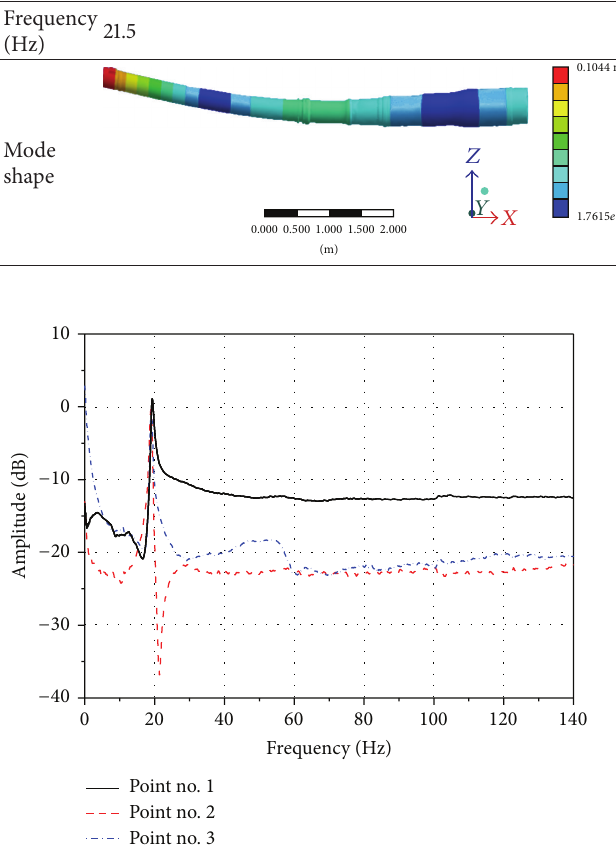
Figure 13: Frequency response functions of beam with and without